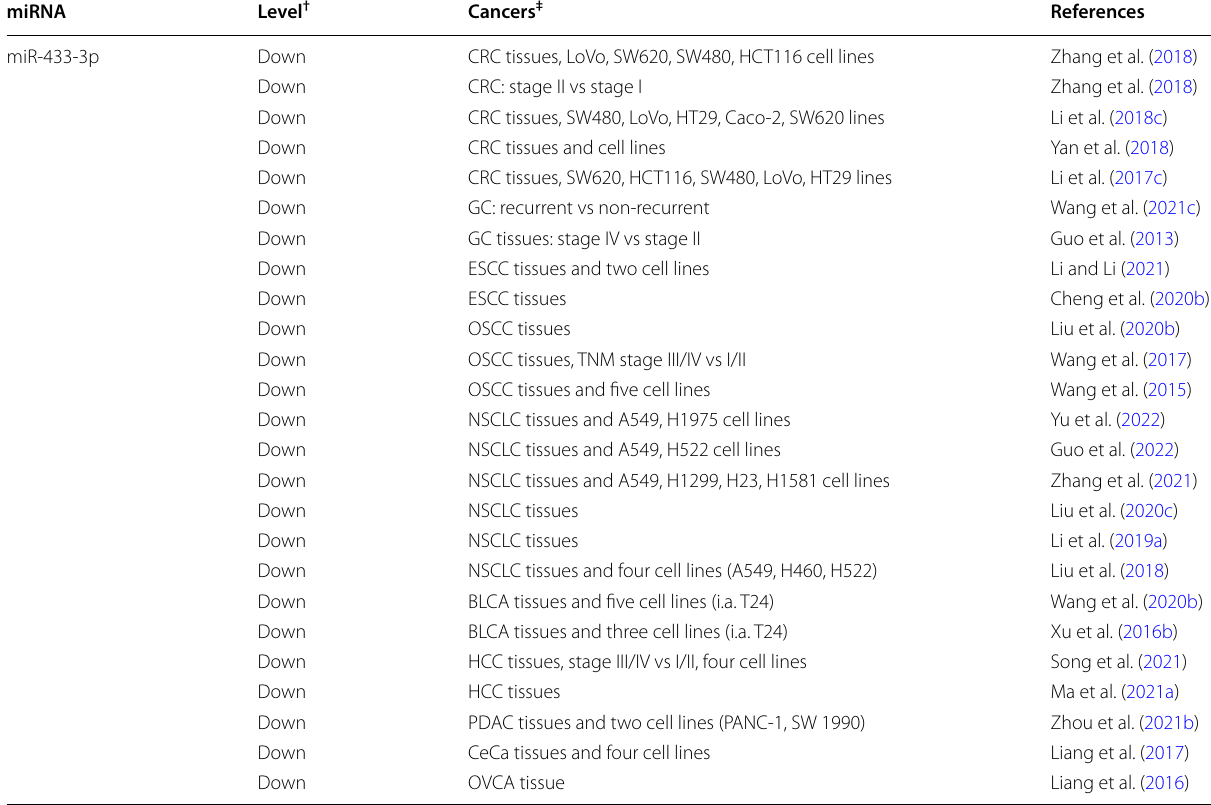
† , ‡ For description see footnote to Table 2